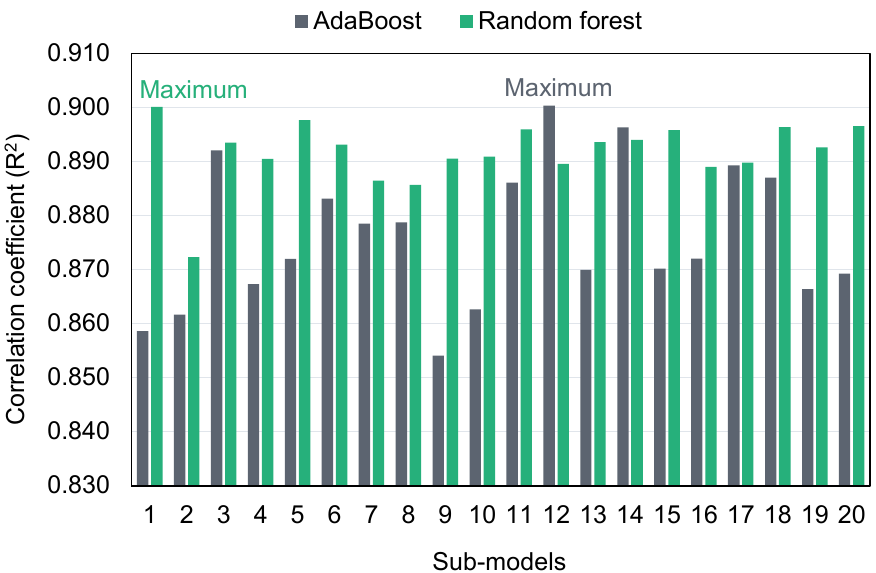
Figure 13. Coefficient of determination of sub-models.